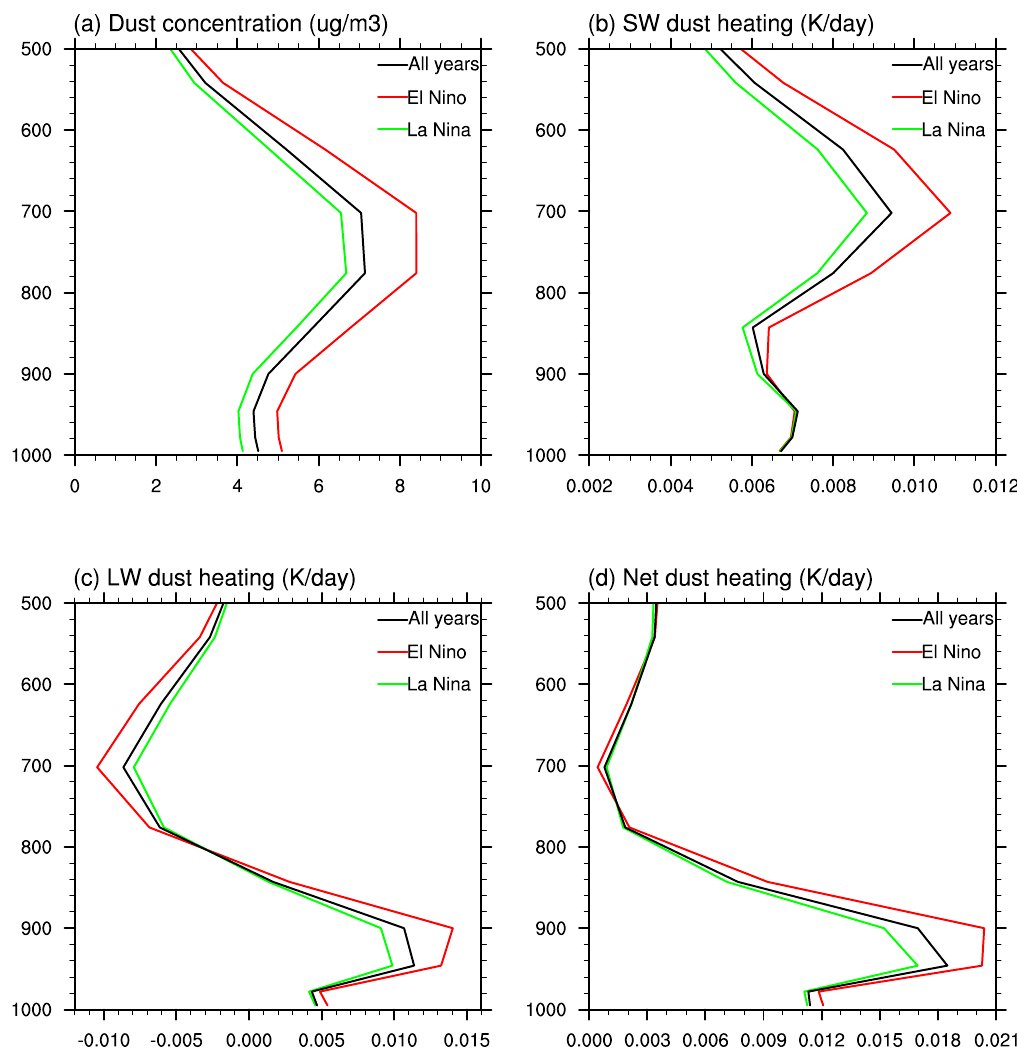
Fig. 14. Vertical atmospheric profiles from the DUST run, averaged over a region in the south-west Pacific Ocean (155–170 ◦ E and 15– 35 ◦ S): (a) dust concentration, (b) shortwave, (c) longwave, (d) net dust radiative heating rates. Composites of El Ni˜no and La Ni˜na years are assembled as described in the